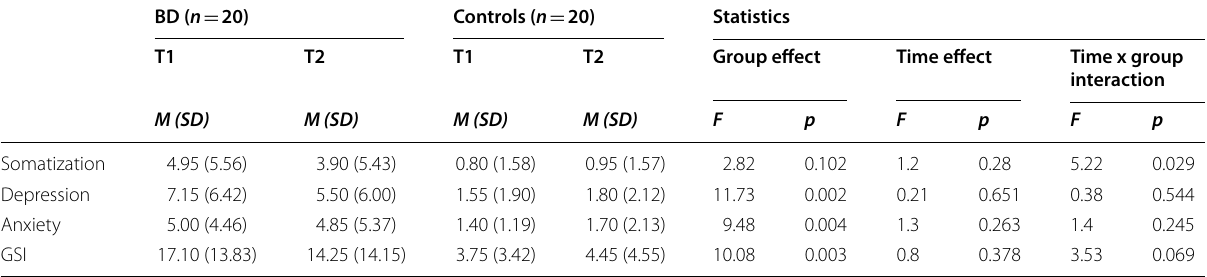
Table 3 Results from repeated measures ANCOVAs: Psychological symptoms (BSI‑18) in patients with BD vs. healthy controls in April (T1) and May 2020